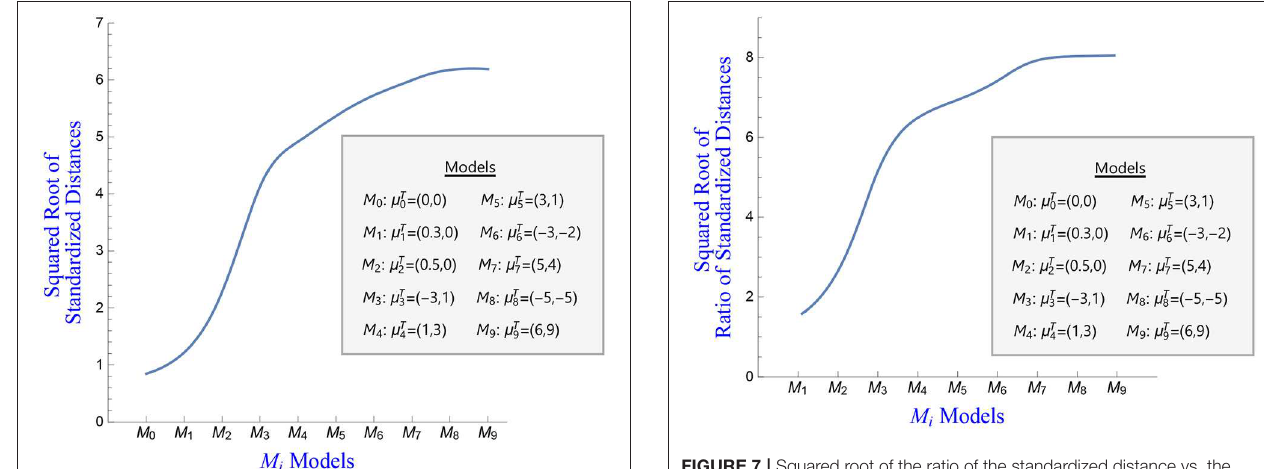
FIGURE 7 | Squared root of the ratio of the standardized distance vs. the various fitted models. Heikertingeri Lubisch , and Chaetocnema Heptapotamica